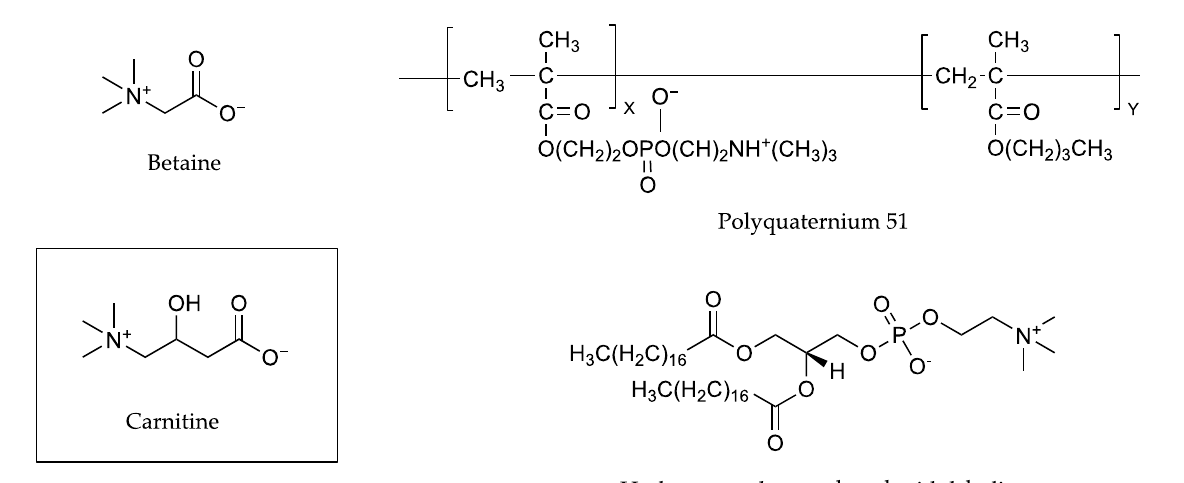
Figure 11. Carnitine with 3 different zwitterion counter ions: betaine, polyquaternium-51 and HSC.